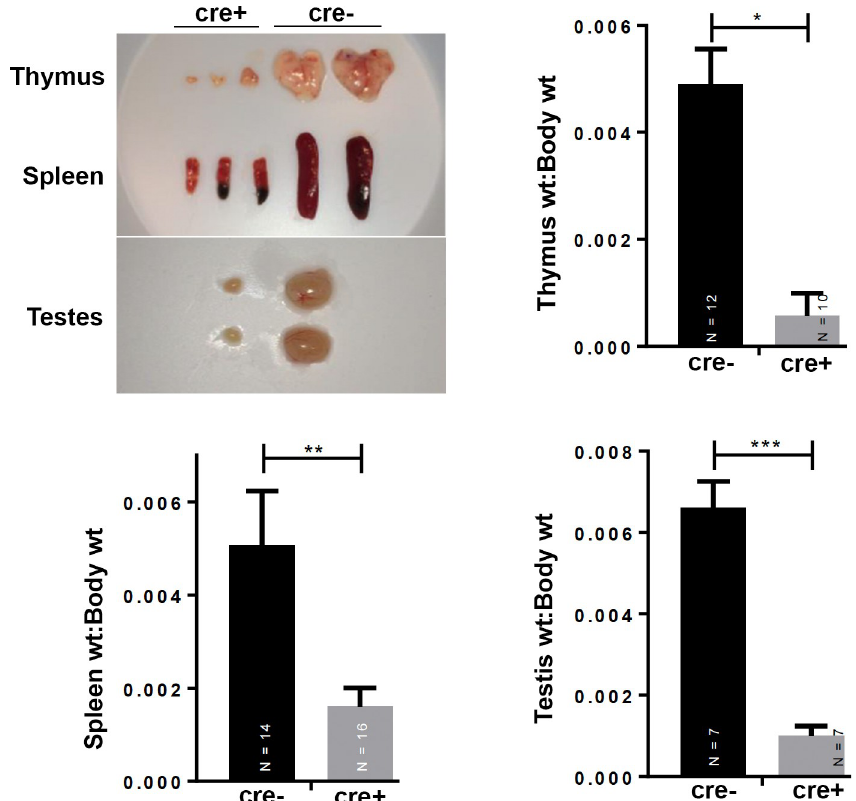
Fig 4. Organ size in Braf CA and Braf CA Tg(CD207-cre) mice. Photographs of representative thymi and spleens, from 31 day old mice, and testes from 39 day old Braf CA Tg(CD207-cre) (cre+) and Braf CA (cre-) mice. Bar graphs indicate the mean ratio of organ weight (thymus, spleen, testis) to body weight for the indicated Braf CA (cre-) and Braf CA Tg (CD207-cre) (cre+) mice. Thymi and spleens were from 30 to 50 day old mice. Testes were from mice aged 30 to 41 days. Comparisons made by two-sided Welch t-test: � , p = 8.85 x 10 − 14 ; �� , p = 1.43 x 10 − 8 ; ��� , p = 3.69 x 10 − 8